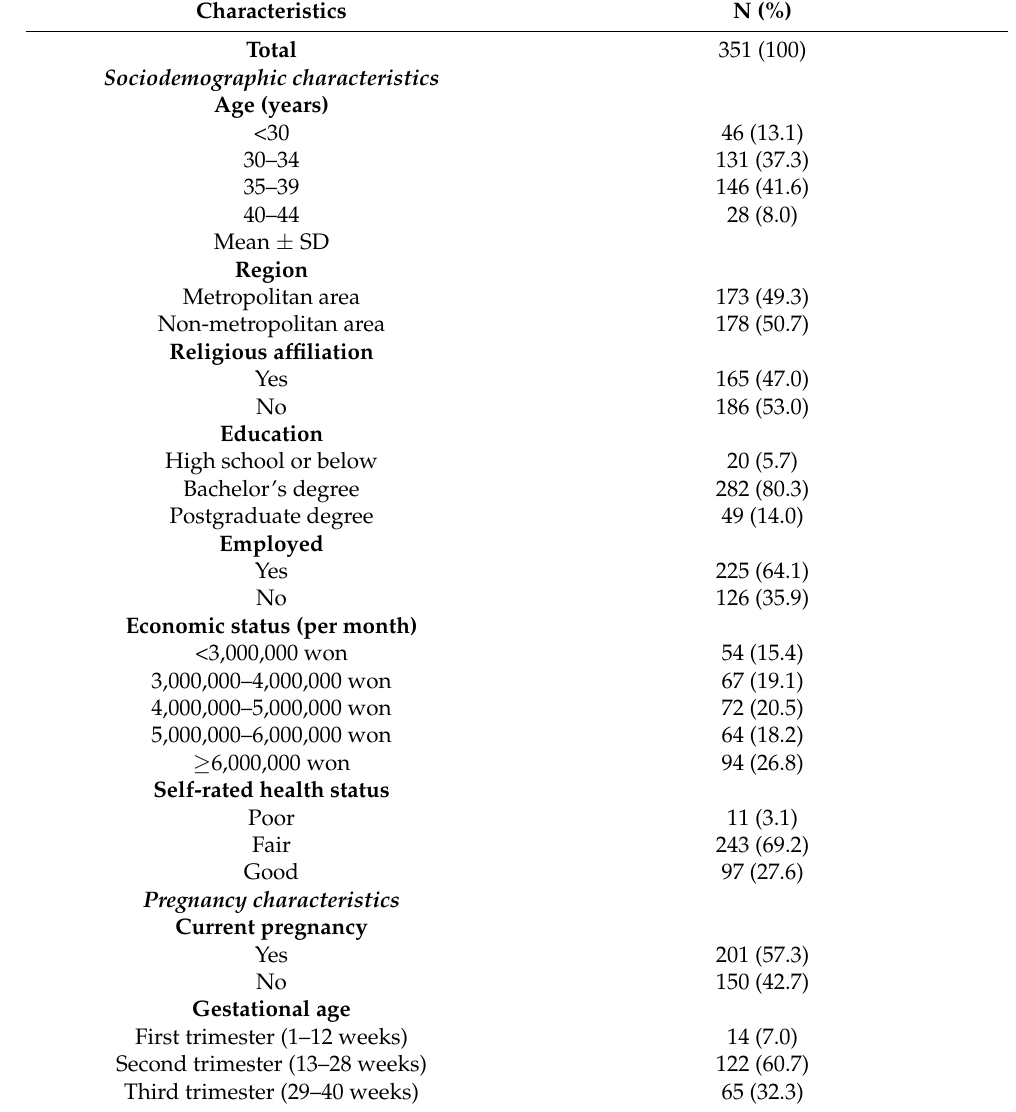
Table 1. Sociodemographic and pregnancy characteristics of the study